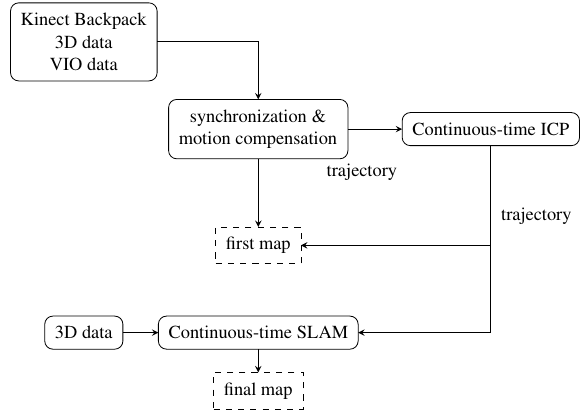
Figure 4. Data processing chain: An initial result created using visual-inertial odometry is further optimized with continuous-time ICP and continuous-time